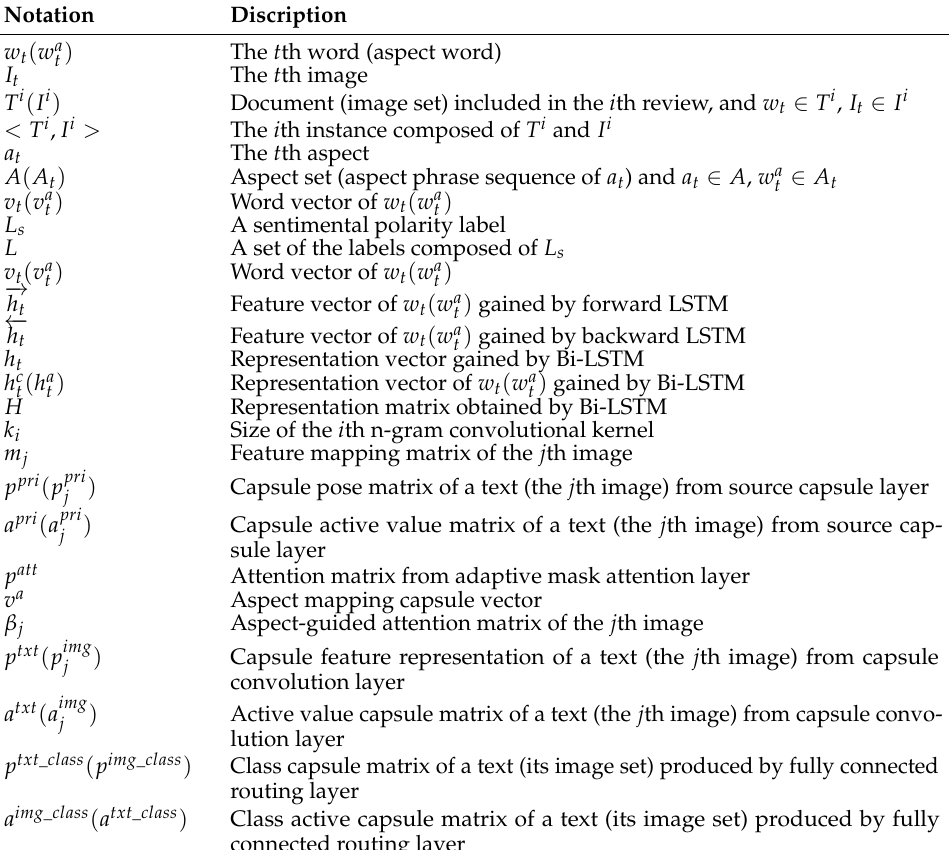
Table 1. Description of the basic notations of